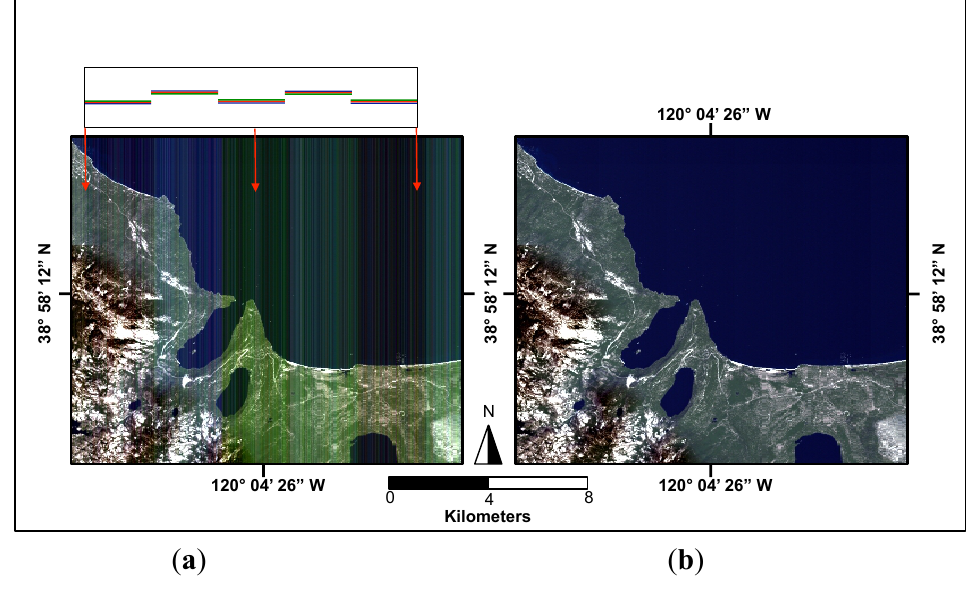
Figure 1. Focal plane design of a typical pushbroom sensor used to simulate data of Lake Tahoe, California with all non-uniformity effects applied ( i.e. , per detector gains, biases, spectral response functions, nonlinearities, noise, etc. ) ( a ) Shows the raw data and ( b ) shows data after